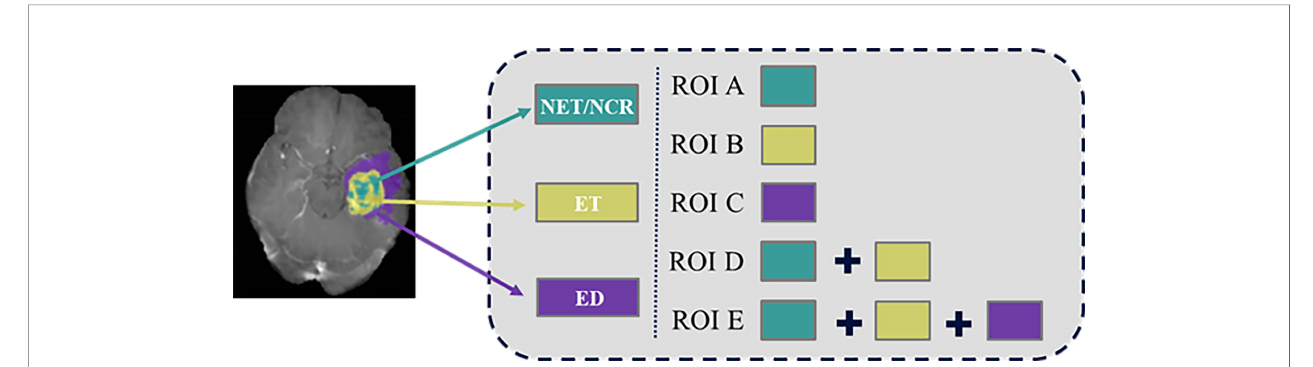
FIGURE 2 | Labeling of the multiple heterogeneous